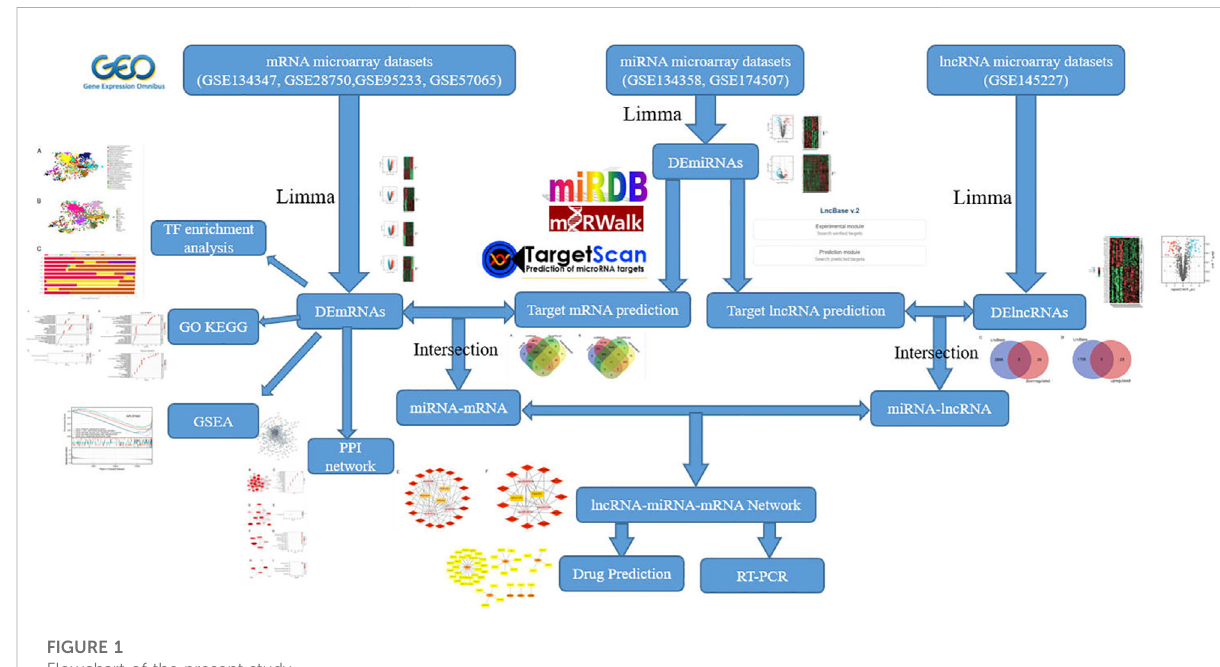
FIGURE 1 Flowchart of the present study.